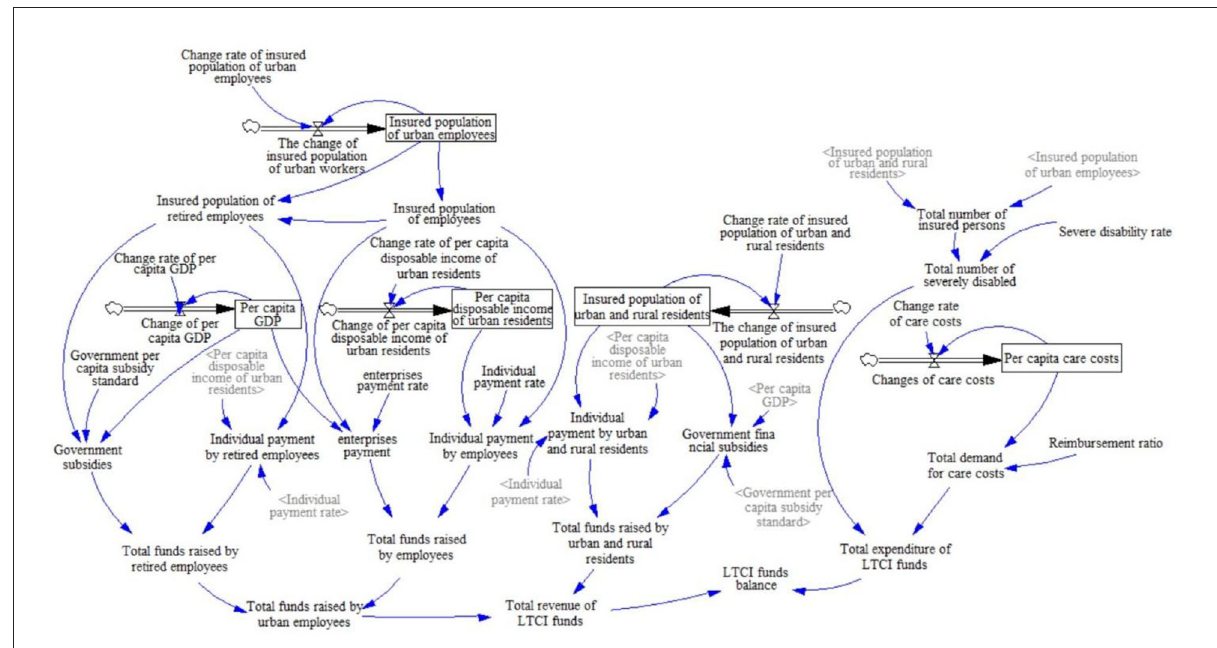
FIGURE1 Flow diagram of long-term care insurance (LTCI) financing